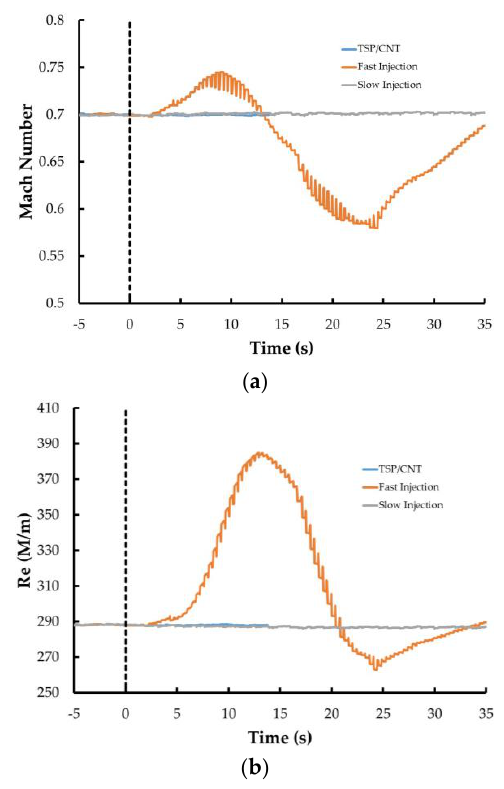
Table 2. Temperature changes on the model surface for conditions shown in Figure